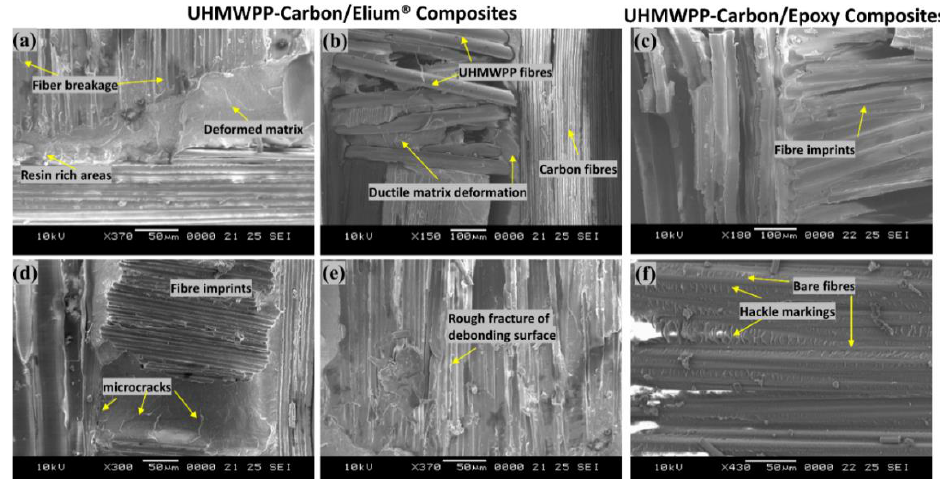
Figure 13 . Surface morphological images of fractured surfaces of composites using Scanning Elec- tron Microscopic approach of ( a , b , d , e ) Carbon_UHMWPP/ Elium ® ( c , f ) Carbon_UHMWPP / Epoxy composites under Mode I loading .